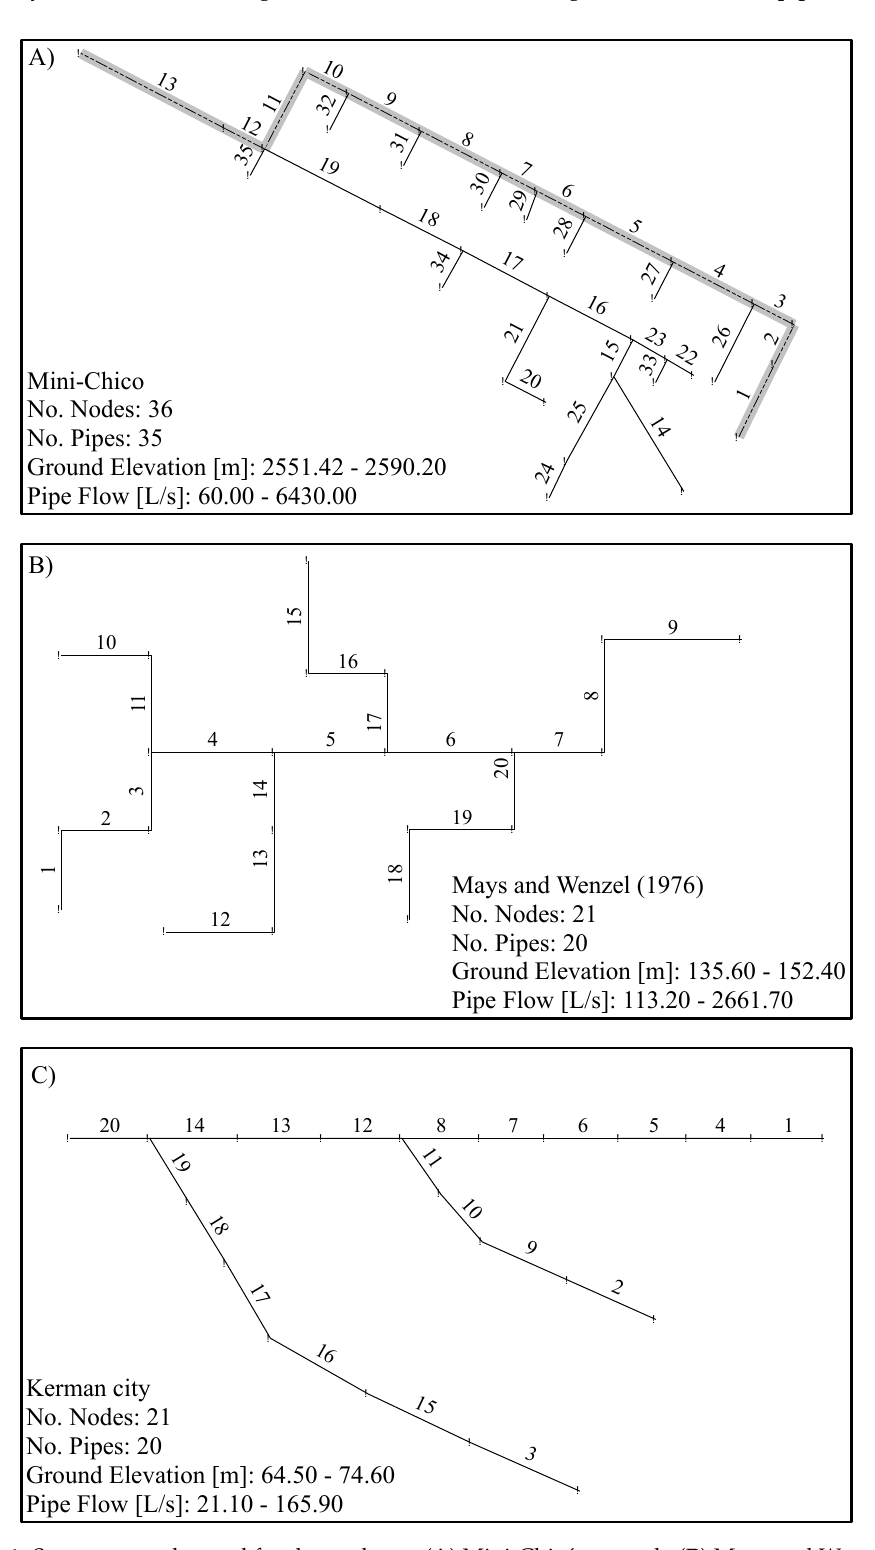
Figure 1. Sewer networks used for the analyses: ( A ) Mini-Chicó network; ( B ) Mays and Wenzel [13] network and ( C ) Kerman city network.